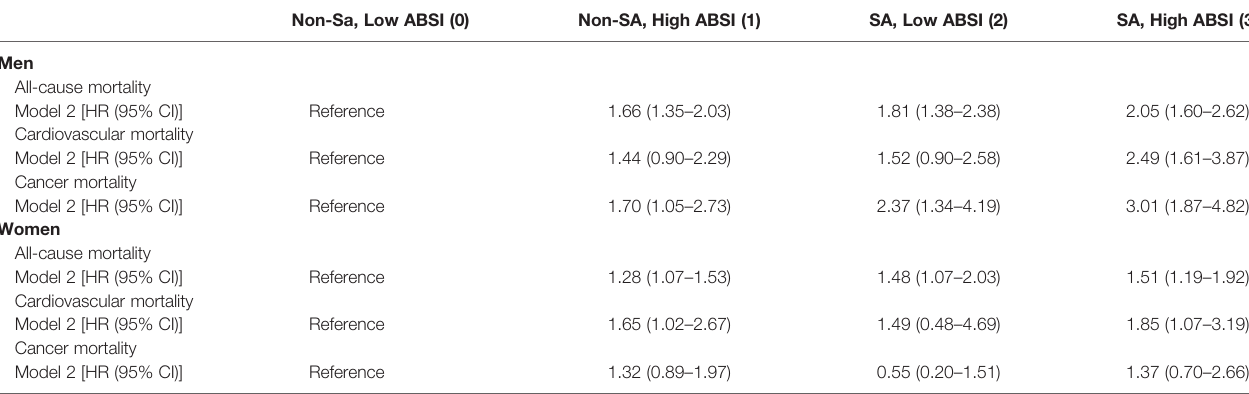
TABLE 3 | Joint association of ABSI and sarcopenia (SA) with all-cause and cause-speci fi c mortality. Non-Sa, Low ABSI (0)